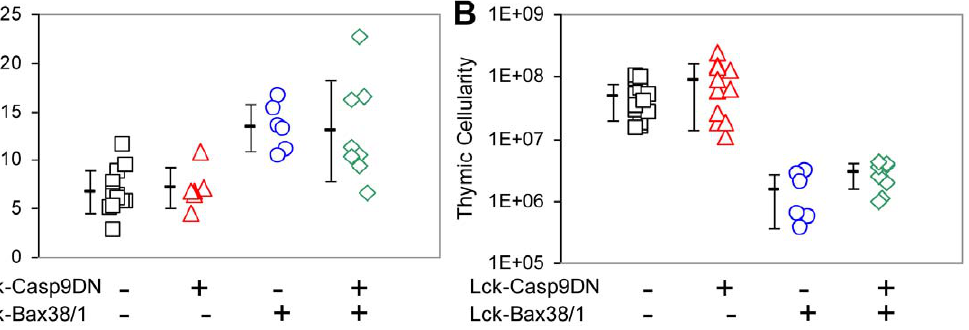
Figure 2. Casp9DN expression has no effect on thymic cellularity and proliferation in Lck-Bax38/1 mice. A ) DNA content analysis was performed on freshly isolated thymocytes from mice of the indicated genotypes between 8 and 10 weeks of age. Each symbol corresponds to the percentage of cycling cells (%S/G2/M) observed from an individual mouse. The mean 6 SD of at least 6 mice per group is shown. B ) Total thymic cellularity from mice of the indicated genotypes between 8 and 10 weeks of age is shown. Each symbol corresponds to the total viable thymocytes number observed from an individual mouse. The mean 6 SD of at least 6 mice per group is shown.